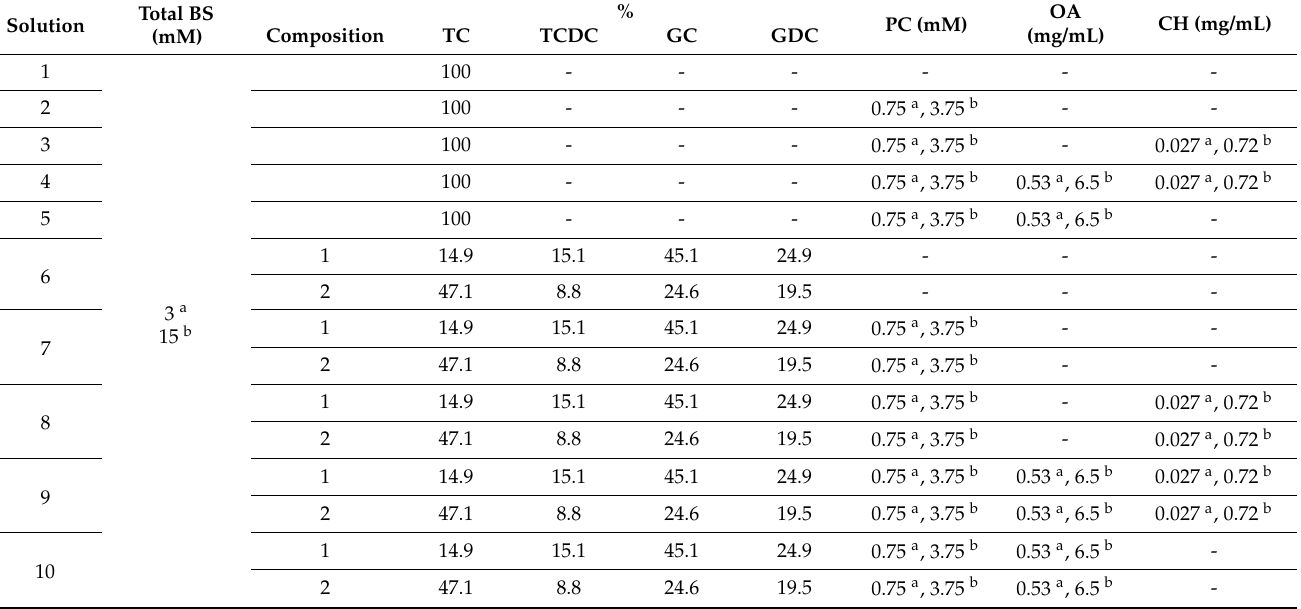
Table 2. Composition of FaSSIF and FeSSIF media used to measure GSK254 equilibrium solubility (24